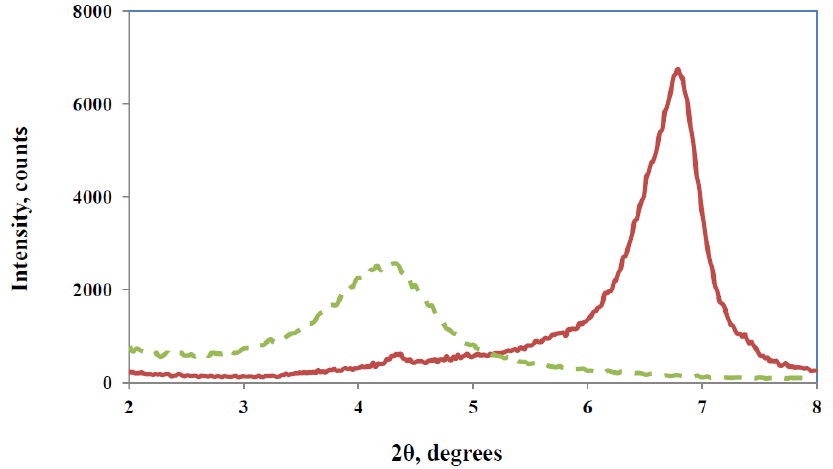
·MEA (red solid 3